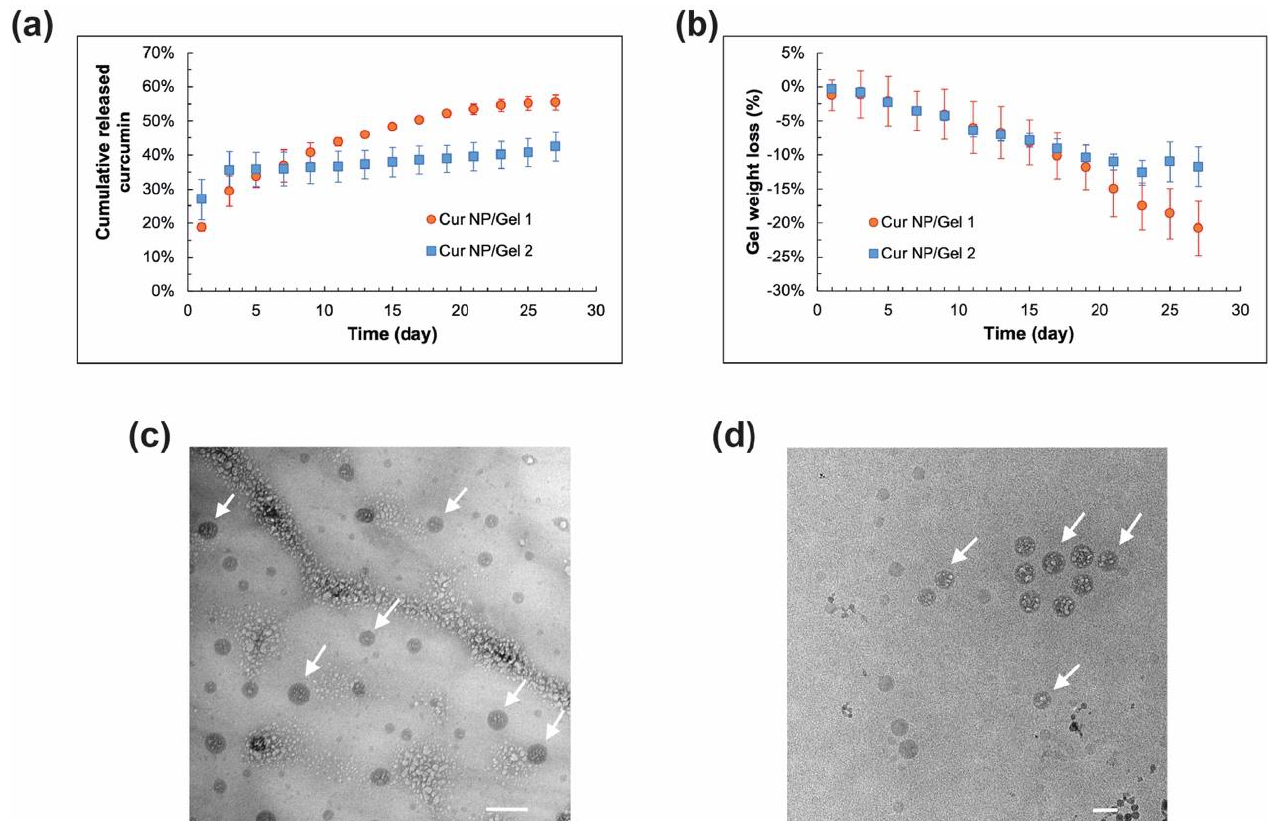
Figure 8. ( a ) In vitro curcumin release profiles and ( b ) weight loss profiles of curcumin nanoparticles (Cur NP)/Gel 1 and Cur NP/Gel 2 composites in saline containing 10% ( w / v ) Tween 80, 0.1% ( w / v ) N-acetylcysteine (NAC), and 0.01% ( w / v ) butylated hydroxytoluene (BHT) at 37 °C ( n = 3). ( c ) Cryo-TEM image of the representative day-5 release sample of Cur NP/Gel 1 composite. ( d ) Cryo-TEM image of Cur NP dispersed in water as a control. Arrows indicate NP. Scale bar: 100 nm.